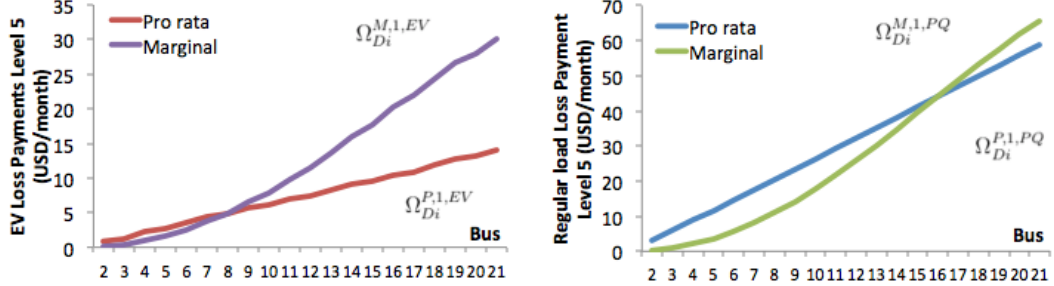
Figure 12. Peak load scenario: economic allocation between PQ and EV users connected at phase 1 (Level